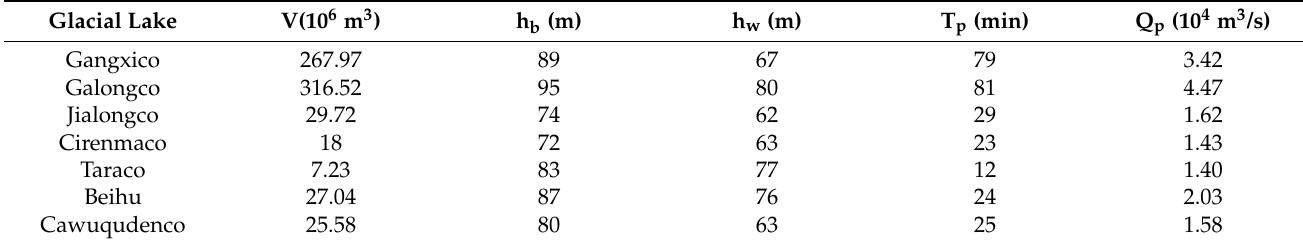
Table 2. GLOF parameters from a complete